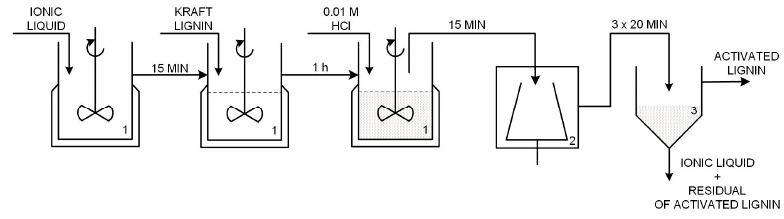
Figure 17. Technological process for the activation of lignin by the ionic liquids (1—reactor, 2—centrifuge tube, 3—gravity filter).